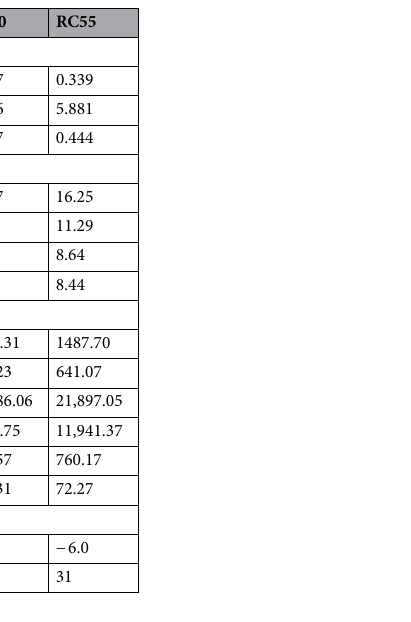
Table 2. Summary of test results under internal blast